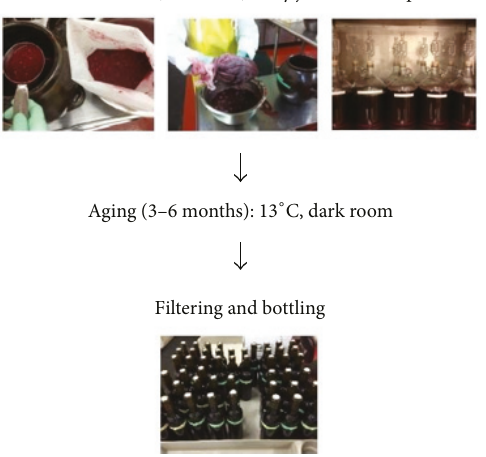
Figure 1: Overview of Korean traditional winemaking